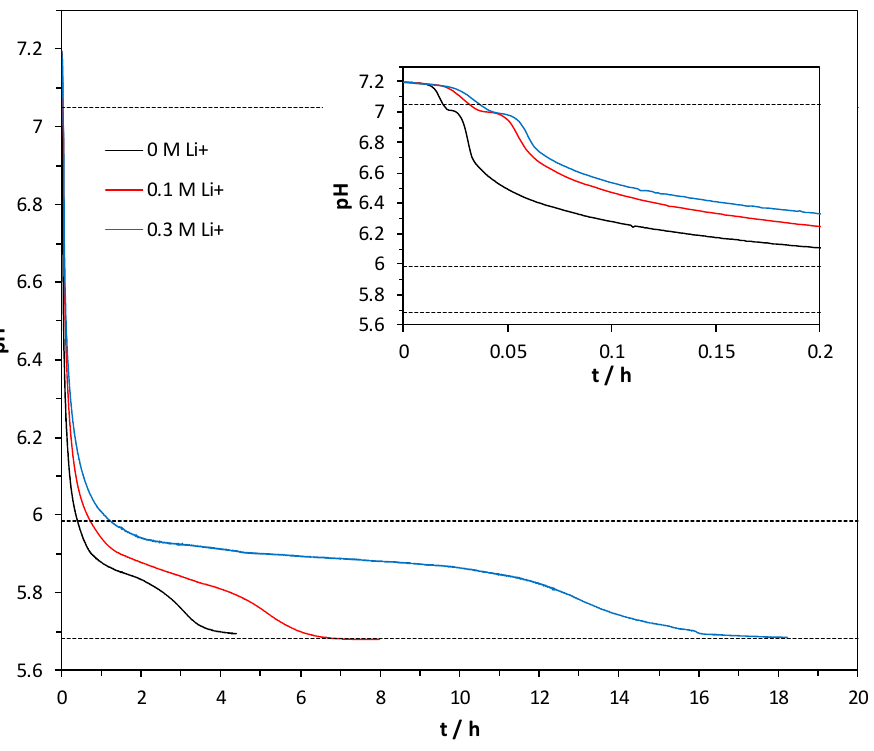
Figure 5. Progress curves, pH vs time of spontaneous precipitation of calcium carbonate: c i (CaCl 2 ) = c i (NaHCO 3 ) = 0.1 mol dm − 3 and different concentrations of LiCl initially present in the systems. The insert shows the pH changes during the initial 12 min of the process. The last period of the transformation process started after complete disappearance of the vaterite so the calcite growth is an only process in the precipitation system. This period could be observed as a final step of the progress curve at about 2.5, 4.5 and 11.5 h and subsequent approach to equilibrium for calcite (( c s (cal) = 0.0630 mol dm − 3 ) ˆ = (pH = 5.69)). In order to understand the influence of Li + addition on the overall kinetics of vaterite to calcite transformation and corresponding morphological properties of calcite